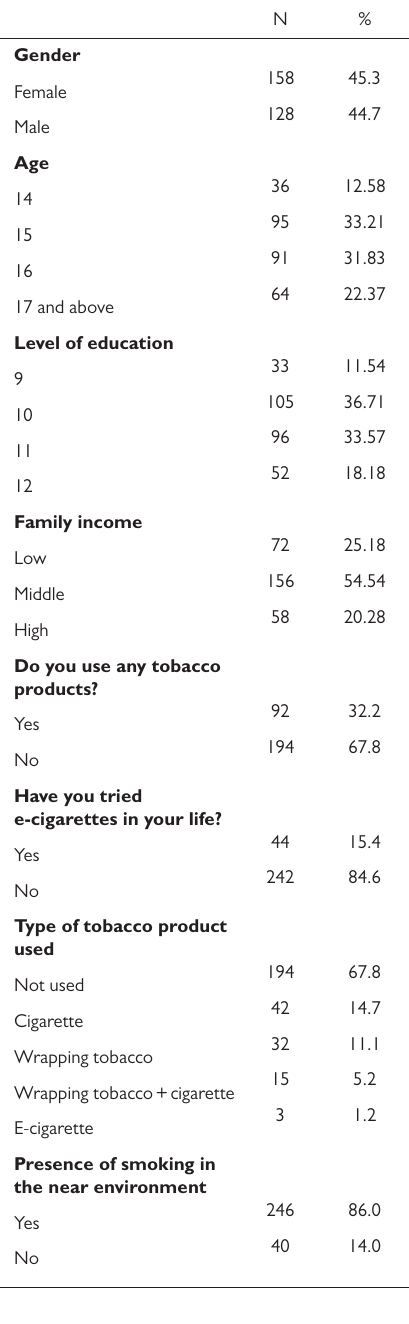
Table 1. Distribution of Some Features Related to Tobacco